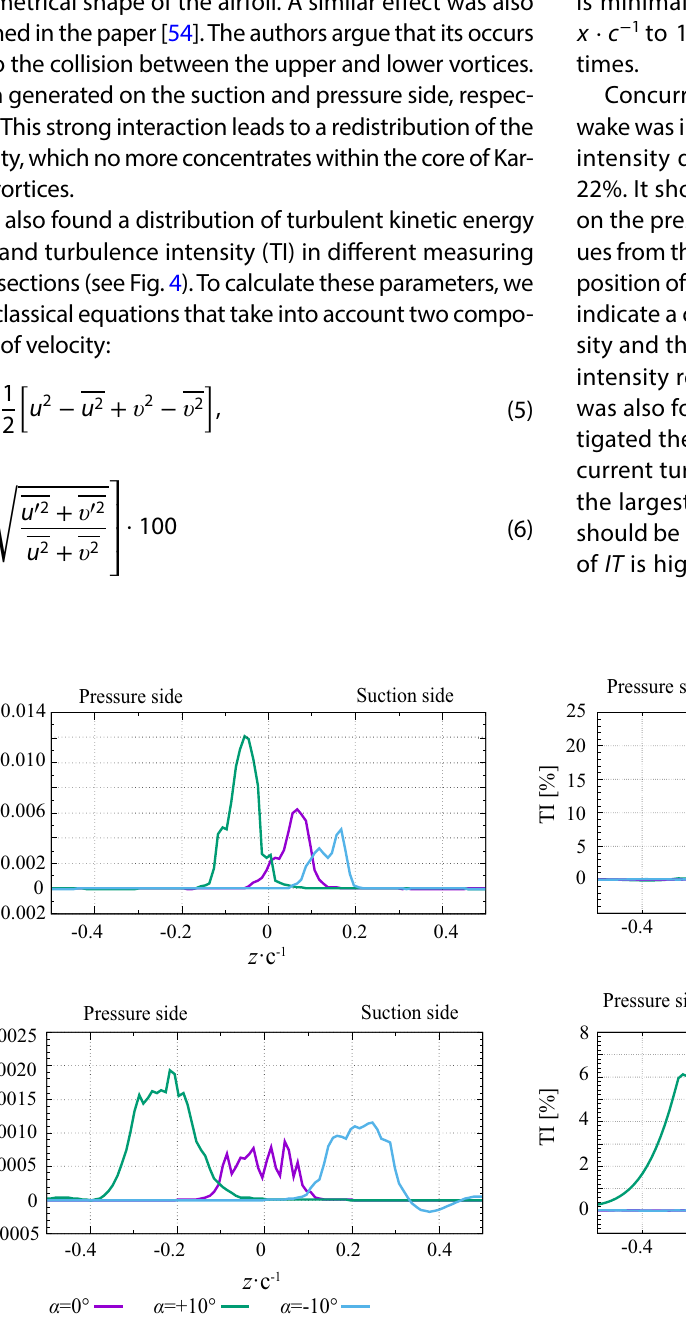
Fig. 4 Distribution of normalized turbulent kinetic energy TKE and turbulence intensity TI at Re ≈ 170 × 10 3 and different x ⋅ c 1 . Green, blue, and light blue indicate the position of the angle of attack 𝛼 = + 10 ◦ ,0 ◦ and − 10 ◦ ,